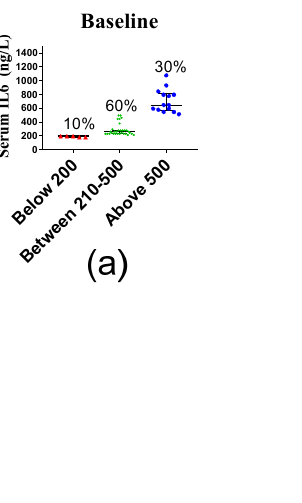
Figure 4. Serum IL6 levels before and after vitamin D supplementation. ( a ) Baseline levels, ( b ) day 1 levels, and ( c ) day 30 levels. ( d ) Columns represent the median serum IL6 concentration at base ‐ line, day 1 and day 30, and error bars indicate interquartile range. Data were analyzed by non ‐ parametric repeated measure ANOVA followed by Wilcoxon signed ‐ rank multiple comparison test. *** p < 0.001.